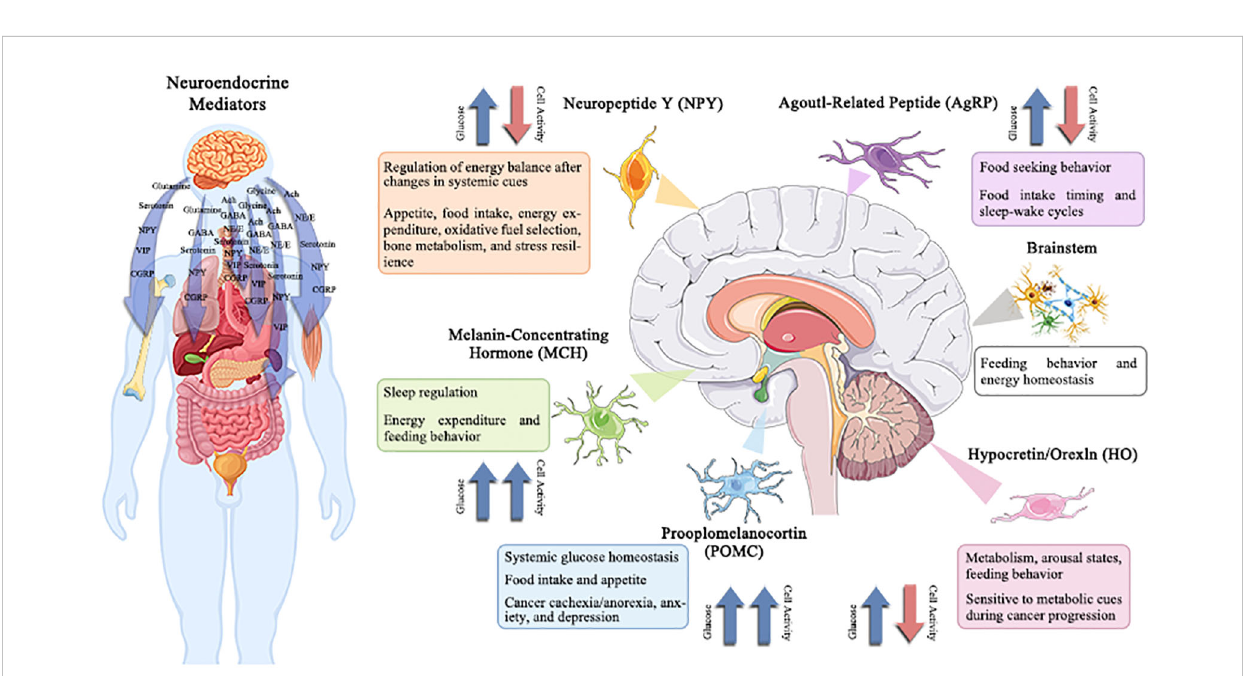
FIGURE 3 Potentially changed glucose-sensitive neuroendocrine mediator in the context of cancer-induced